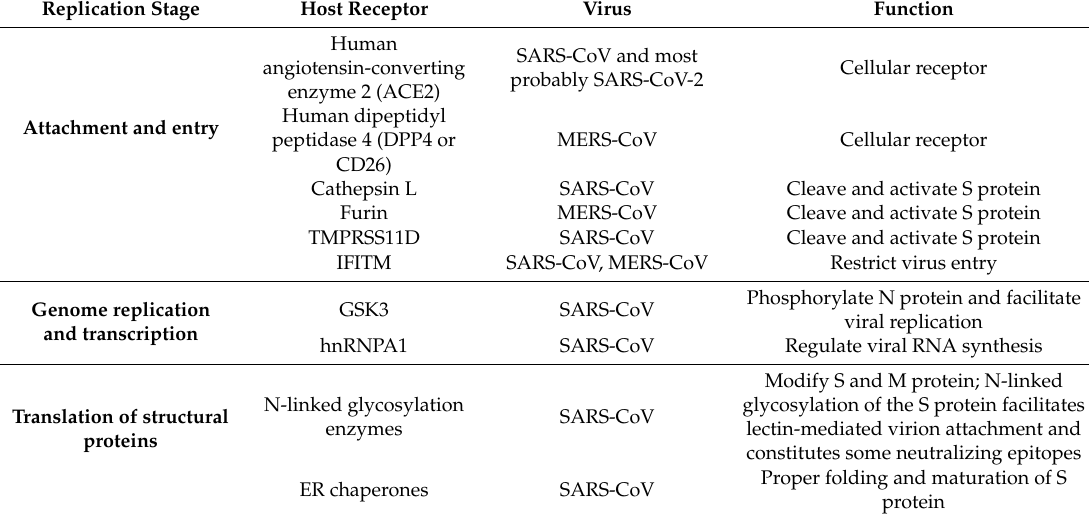
Translation of structural